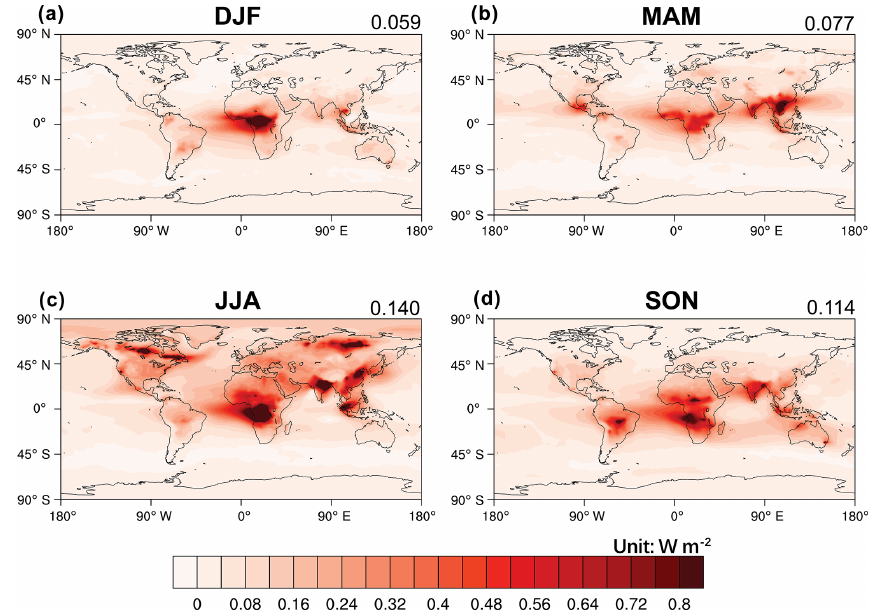
Figure 12. Same as Fig. 10 but for seasonal global DRE distributions of BrC for (a) December–January–February (DJF), (b) March–April–